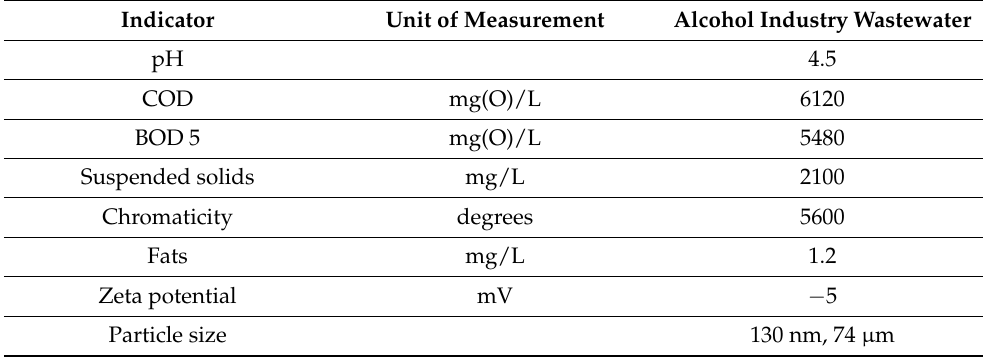
Table 1. Chemical composition of the wastewater samples.